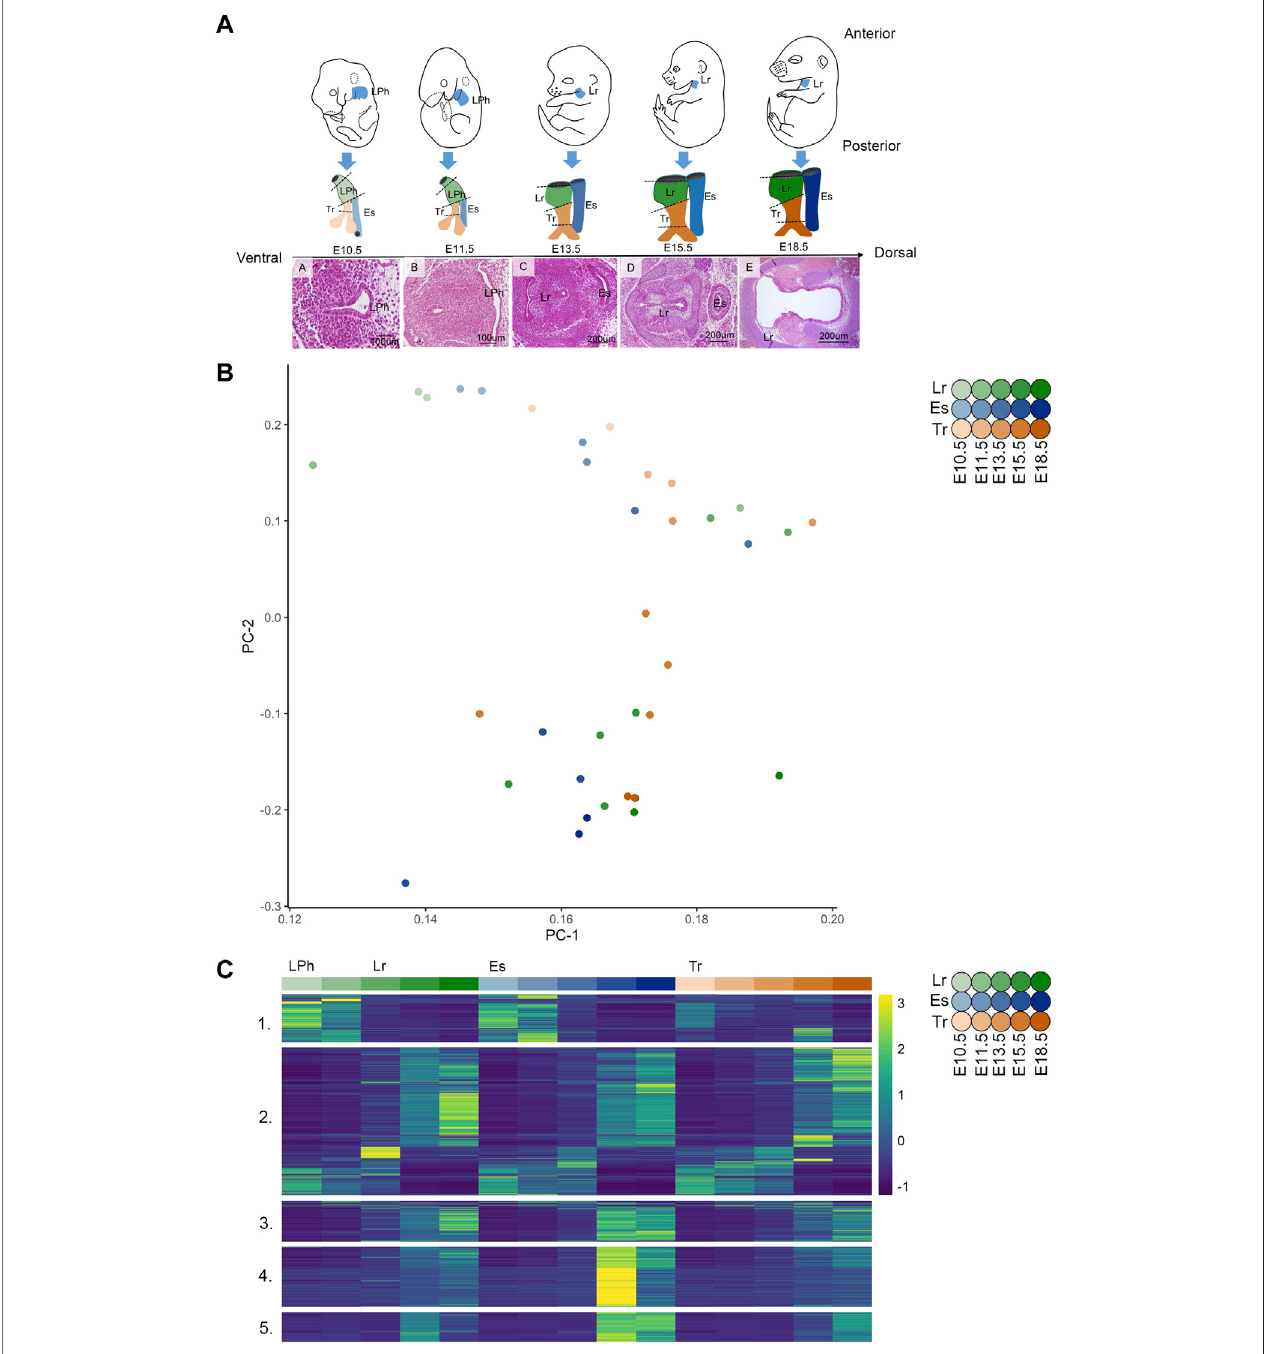
FIGURE 1 | Global transcriptome structure across the esophagus, trachea, and larynx during embryonic development, (A) Schematic of developing embryos shows the color key for organ identity and developmental stage across the study timespan above hematoxylin and eosin histological sections at the level of the developing vocal folds during each time point. (B) PCA analysis demonstrates 2D representation of whole-tissue transcriptome principal components at E10.5, E11.5, E13.5, E15.5, and E18.5 across embryonic development of the Lr, larynx; Es, esophagus; Tr, trachea; (C) Heatmap of differentially expressed genes (DEGs) ( n = 3,472) constructed from normalized expected counts across embryonic developmentof the primitive laryngopharynx(LPh), larynx (Lr), esophagus (Es), and trachea (Tr) at E10.5, E11.5, E13.5, E15.5, and E18.5 with expression measures averaged across replicates within each tissue/age combination and then converted within each gene into a z-score for improved visual